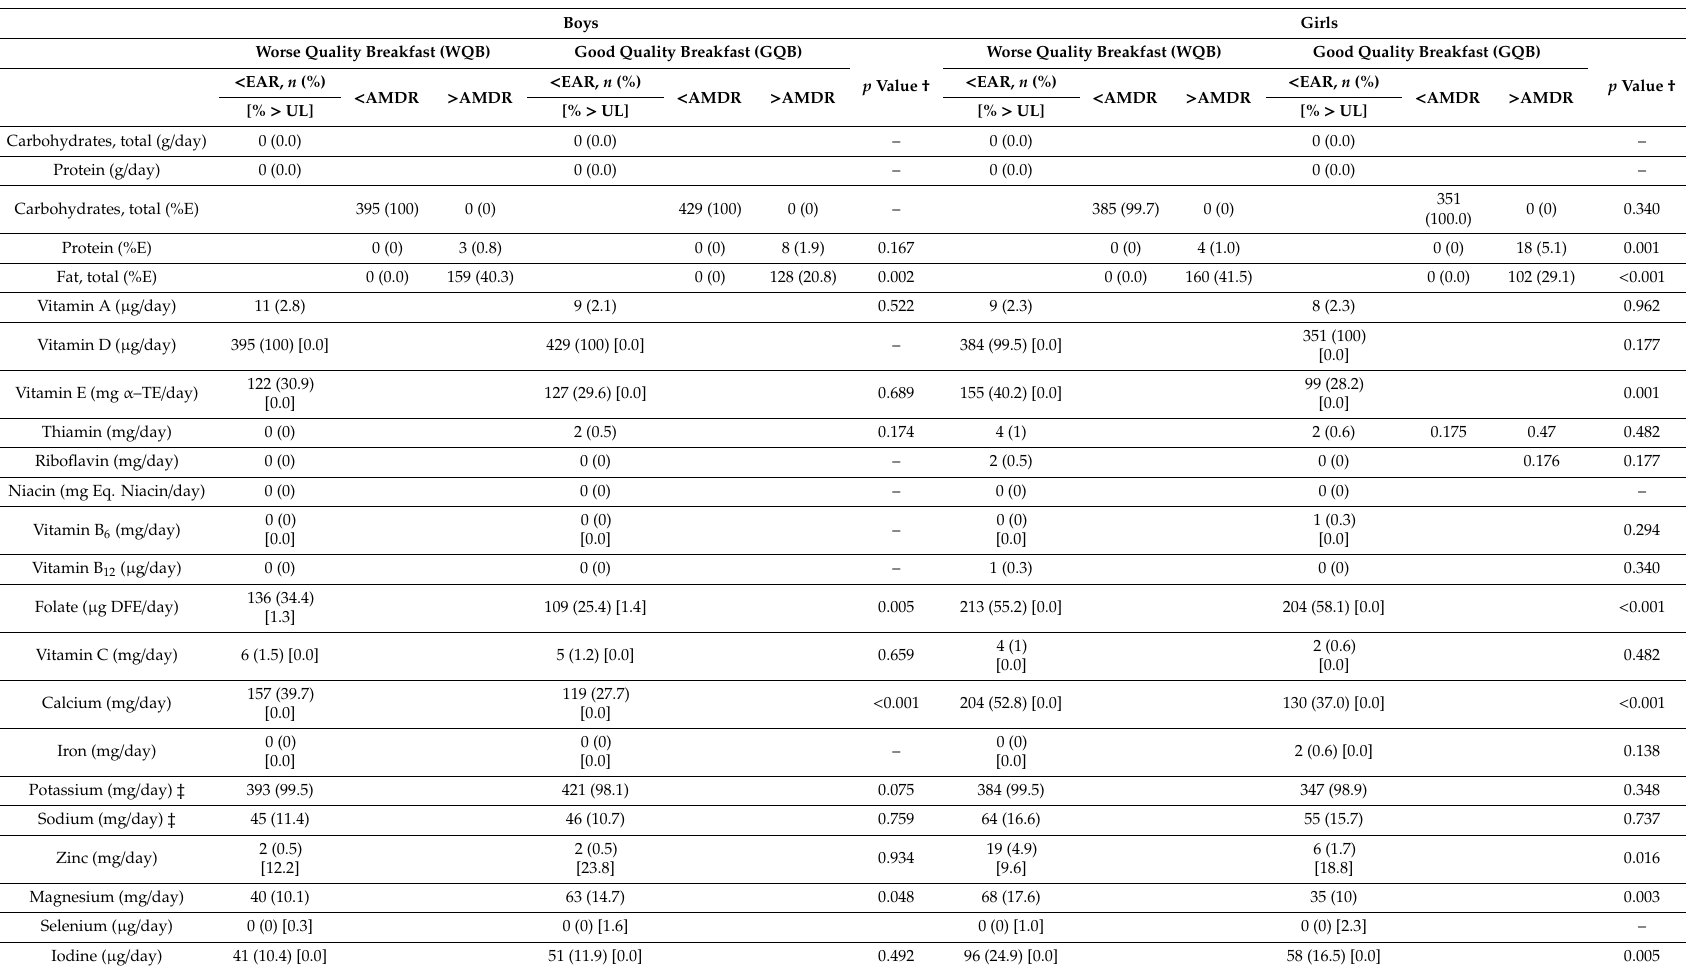
Table 8. Inadequate intakes of macronutrients and micronutrients in Spanish children n (%) by sex and type of breakfast ( n = 1561). Boys